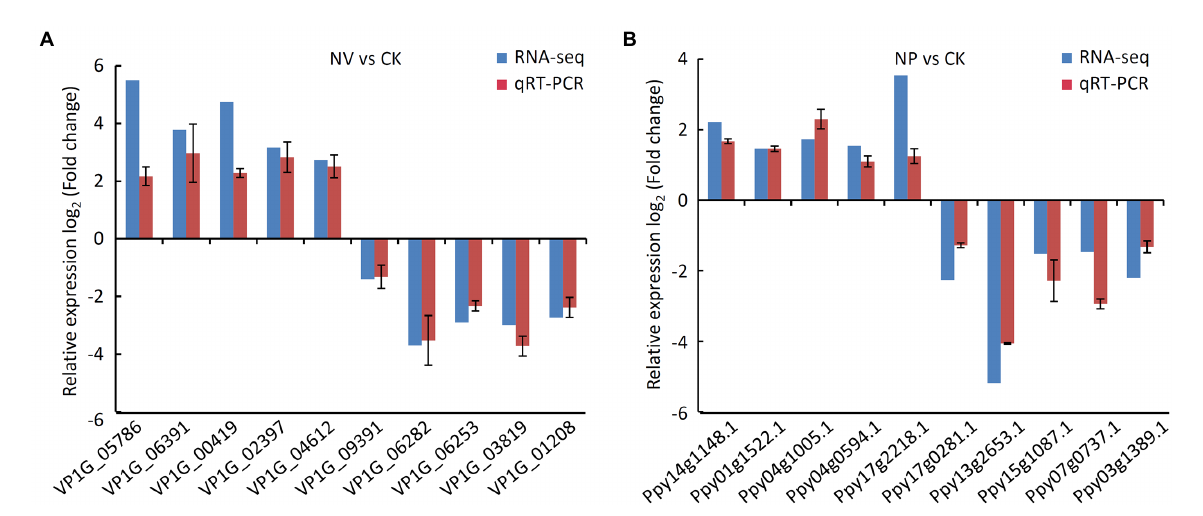
FIGURE 9 Validation the results of RNA-seq by qRT-PCR assay. (A) qRT-PCR assay in V. pyri . CK, untreated V. pyri ; NV, strain Nl4-treated V. pyri . (B) qRT-PCR assay in pear twigs. CK, LB-treated pear twigs; NP, strain Nl4-treated pear